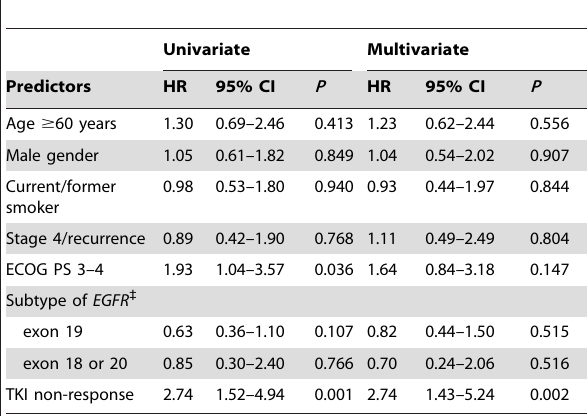
Table 3. Analysis of variables associated with overall survival in NSCLC EGFR -mutant patients.